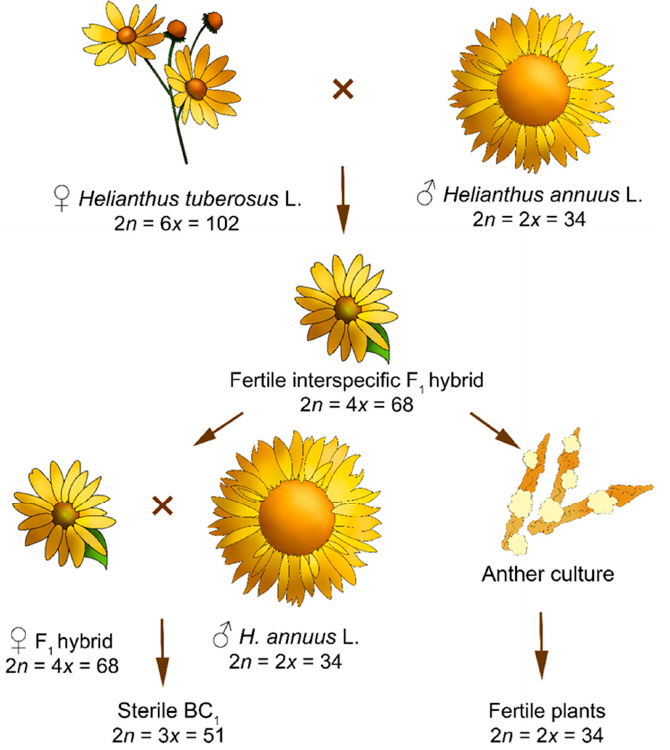
Figure 5. Manipulation of ploidy level in the anther culture of an interspecific hybrid between cul- tivated sunflower and H. tuberosus L. [17].